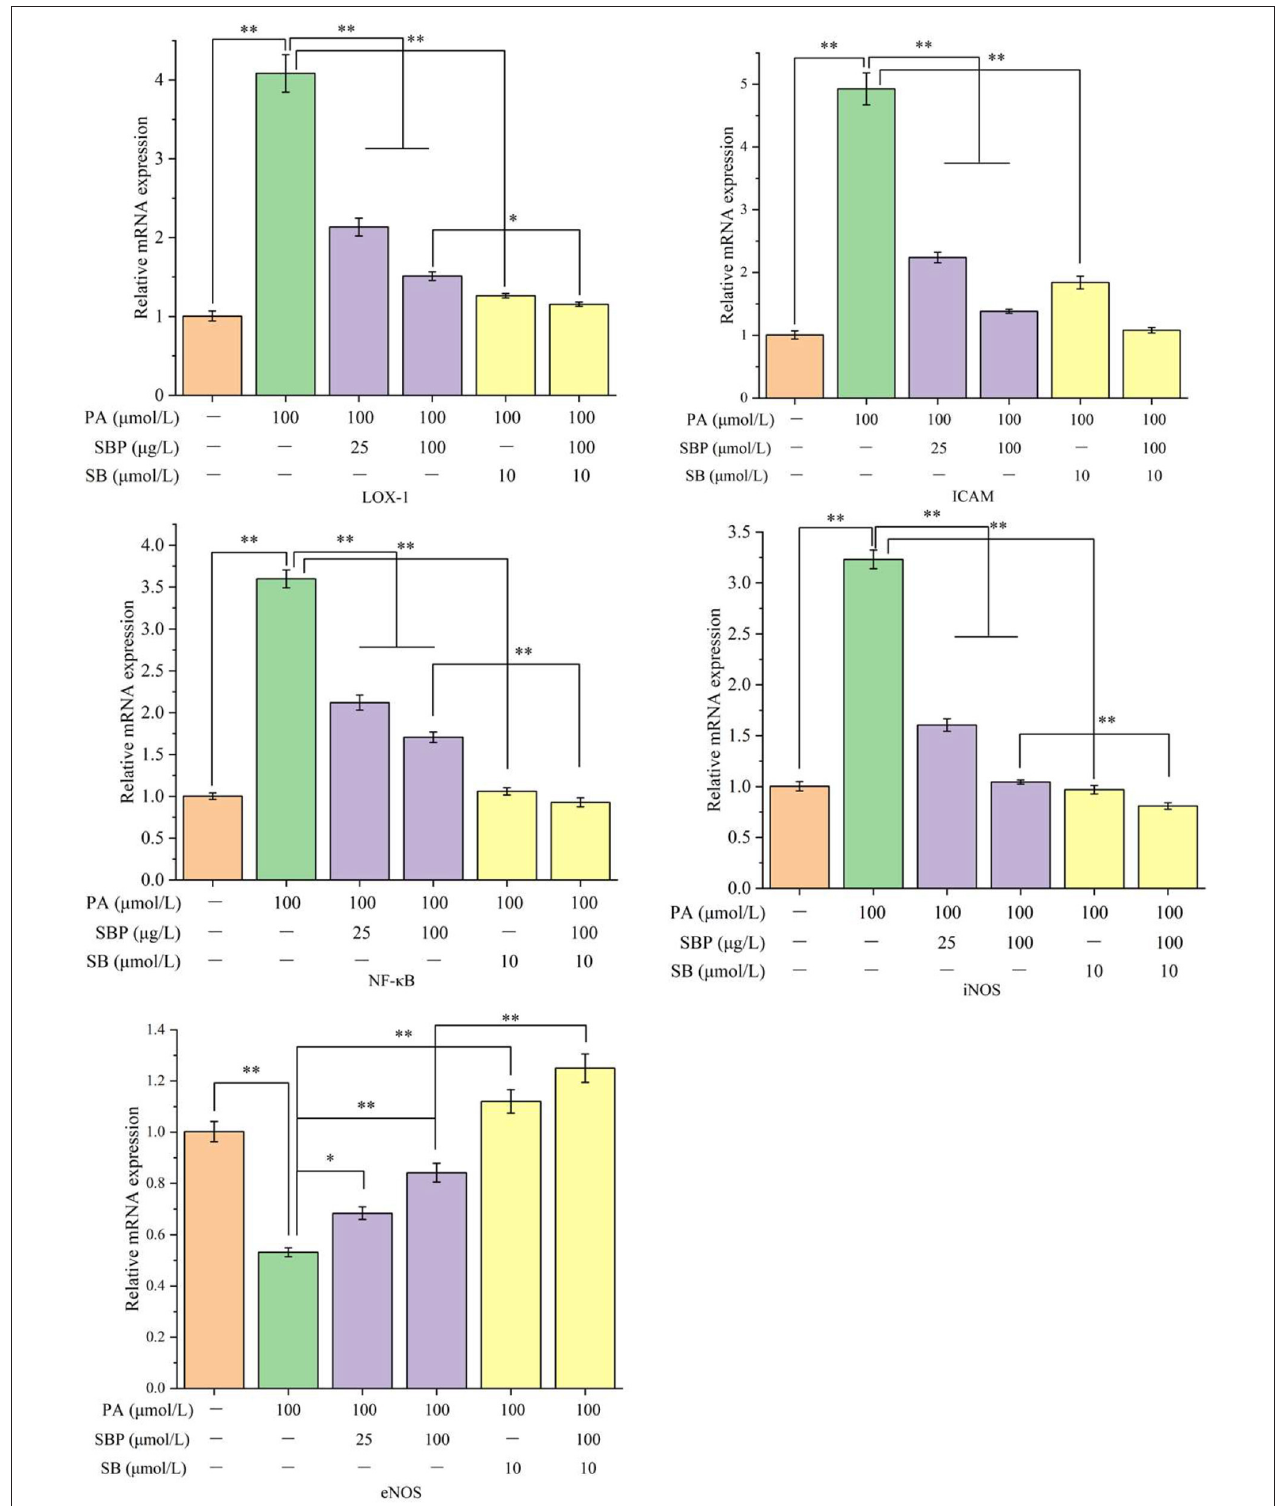
FIGURE 3 | Relative mRNA expression (LOX-1, ICAM, NF- κ B, iNOS, and eNOS) under different treatments of SBP and SB. The results were expressed as the mean ± SD ( n = 3). * p < 0.05 and ** p < 0.01.